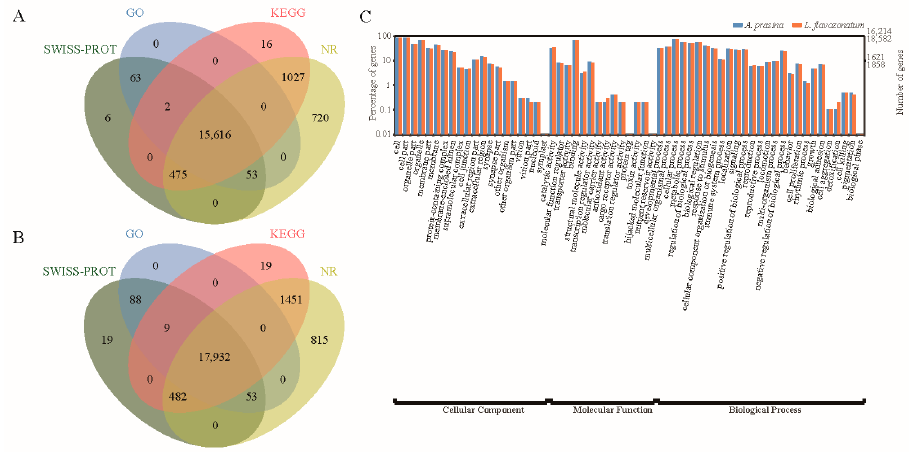
Figure 2. Annotative summary of de novo transcriptome assembly. ( A ) Annotated unigenes of A. prasina and ( B ) L. flavozonatum from 4 different databases. ( C ) Comparison of Gene Ontology (GO) classifications based on de novo transcriptome assembly of two snakes .